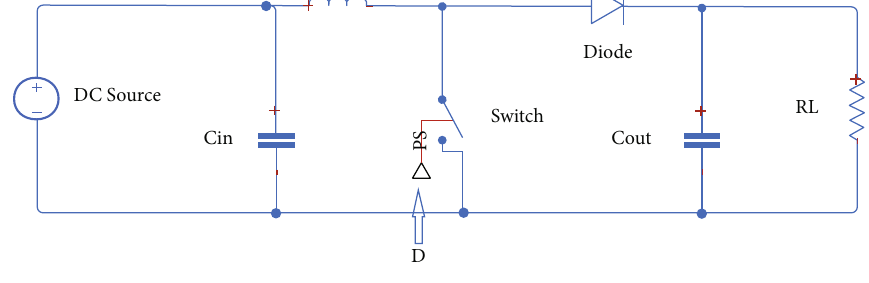
Figure 2: Boost converter.